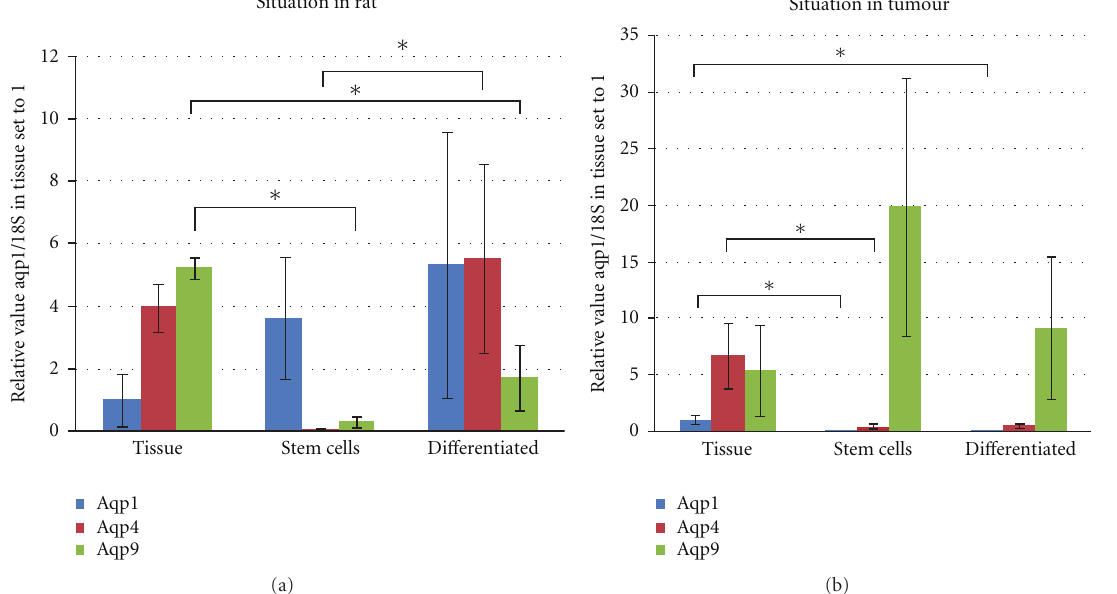
Figure 1: q-PCR analysis of mRNA expression of aquaporins 1, 4, and 9 in rat versus glioblastoma. (a) Levels of aquaporins in rat tissues. Progenitors mainly express aqp1. Di ff erentiated cells expressed all three with aqp9 expressed the least. ∗ values that di ff er statistically using unpaired two-sampled Student’s t- test and considered significant when P < 0 . 05. (b) Levels of aquaporins in tumour tissues. In the progenitor and di ff erentiated cell populations, aqp9 was conspicuously dominant compared to aqp1 and 4. ∗ values that di ff er statistically using unpaired two-sampled Student’s t- test and considered significant when P < 0 .